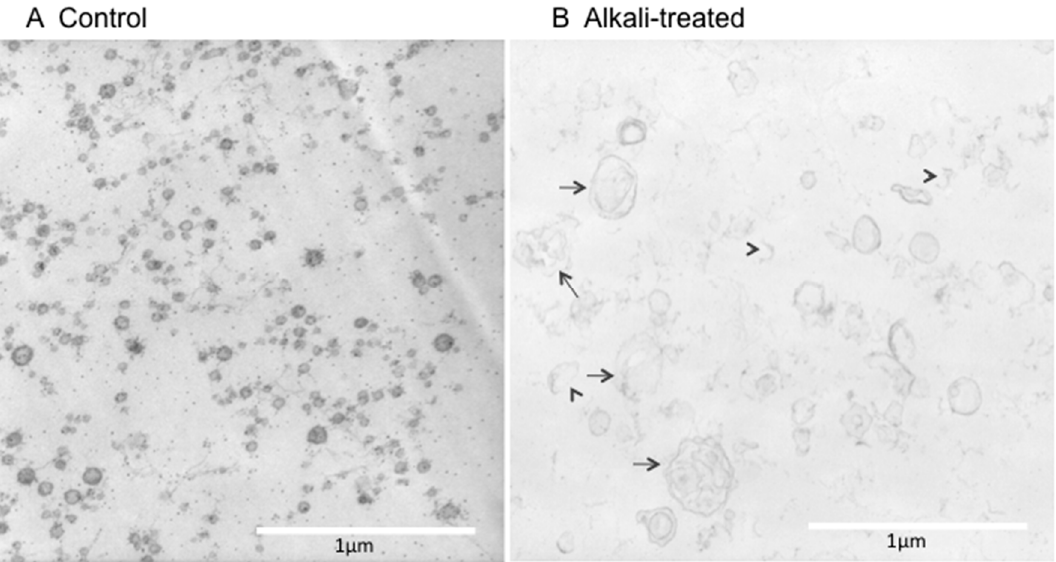
Figure 1. Electron microscope (EM) observation of extracellular vesicles (EVs). ( A ) Control: EV samples obtained from normal urine showed abundant 20–100-nm vesicles; ( B ) Alkali-treated: Urine samples were pre-treated with 0.4 N of NaOH and 0.5% Triton X-305 for 20 min followed by neutralization with HCl, and EVs were obtained in a similar manner. Disruption of EV membranes (arrow heads) and large vesicles composed of fused vesicles (arrows) were observed.